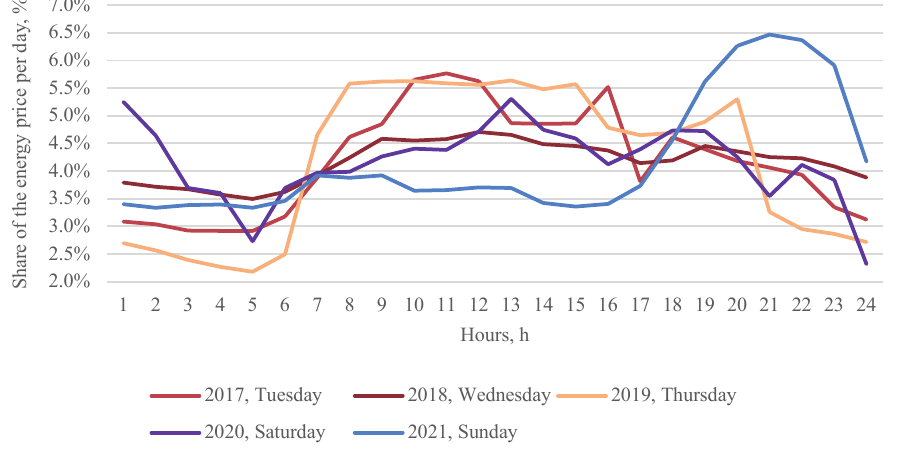
Fig. 5. The share of the energy price per hours on August 15, 2017…2021 [14].